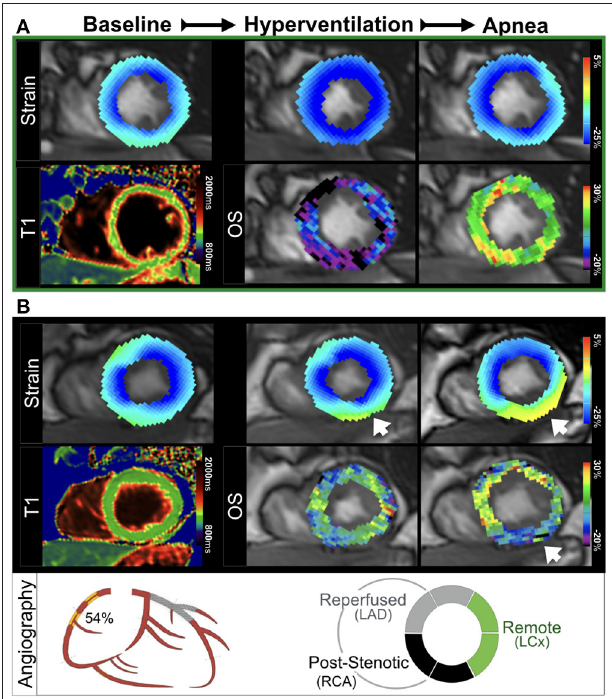
FIGURE 4 | Ventricular dysfunction and myocardial deoxygenation induced by apnea. (A) In a healthy control, hyperventilation (HV) augmented peak strain (PS) homogenously to more negative values. This was accompanied by a HV-induced decrease in OS-SI (blue), followed by an increase of oxygenation (green-yellow) with apnea and normalization of (PS), which is the physiologic response to the breathing maneuver sequence. (B) In a patient ( Figure 2 , patient 1) with an RCA stenosis (QCA 54%) and a stented LAD, a normal PS was observed in the myocardium at rest. Hyperventilation induced a mild peak strain abnormality in the inferior wall that worsened in apnea (yellow, arrow). This functional reduction was colocalized with apnea-induced regional deoxygenation in post-stenotic myocardium (blue-purple). There was no increased native T1 found in this